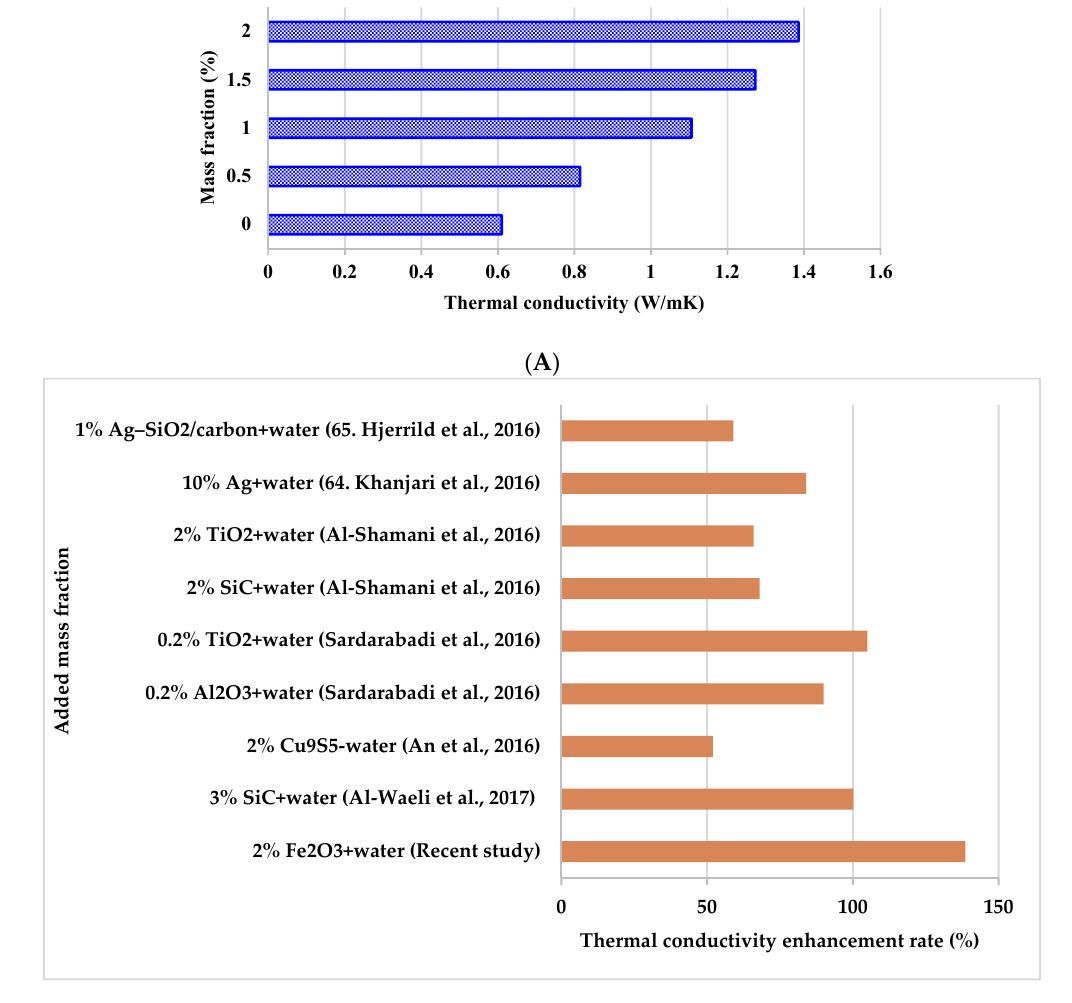
Figure 5. The effect of mass fraction added on resulted nanofluid TC ( A ), and a comparison between recent study TC and others from literature ( B ).